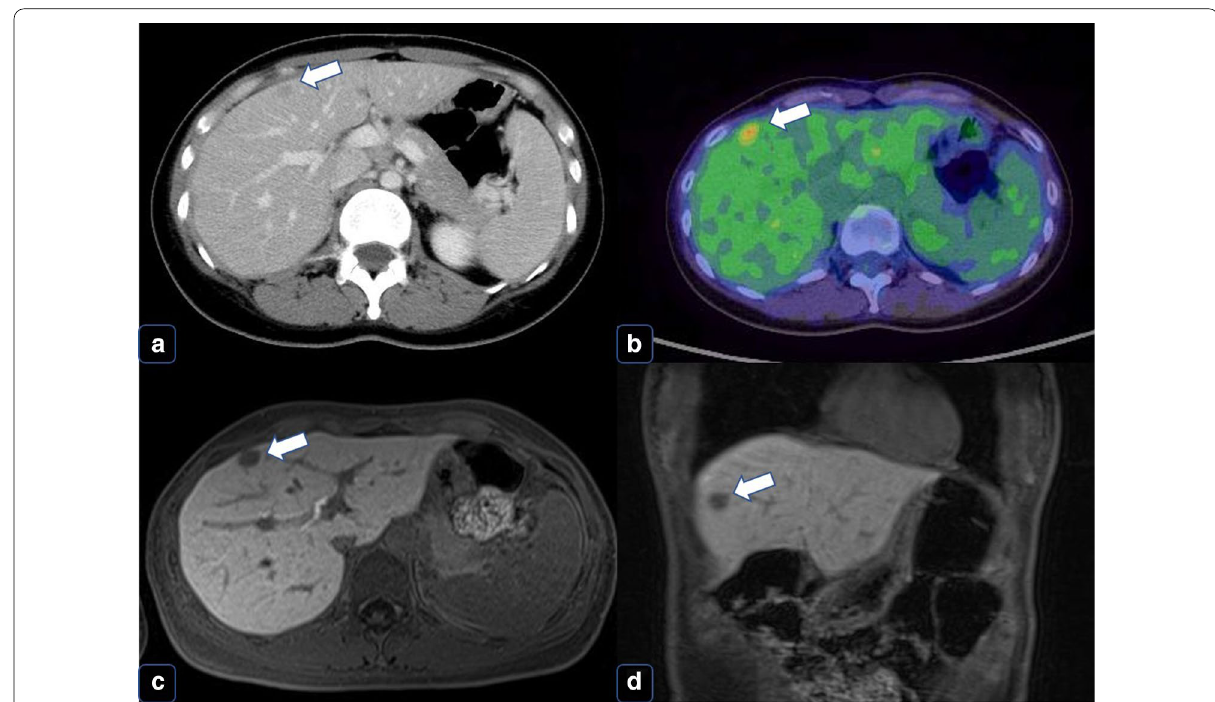
Fig. 6 Findings at a single liver metastasis. a CT. Horizontal view. Liver metastasis (the white arrow). b PET (the white arrow). c EOB-MRI. Horizontal view (the white arrow). d EOB-MRI. Sagittal view (the white